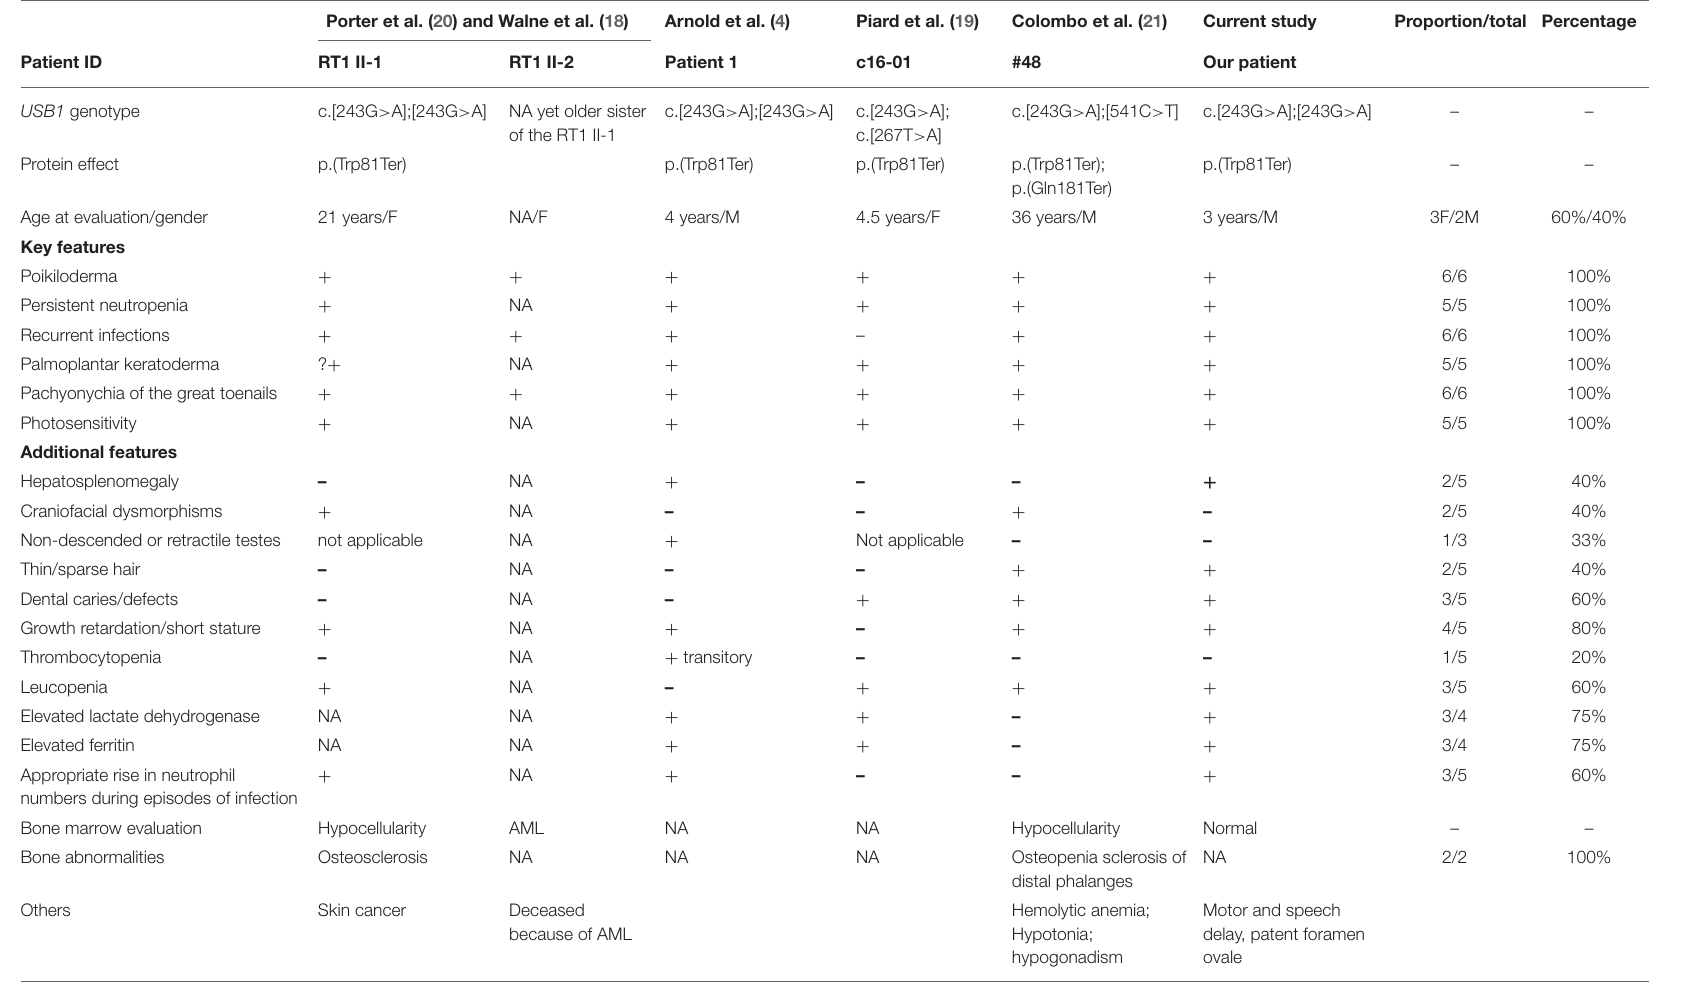
TABLE 1 | Revision of cases with the c.243G > A mutation reported at today together with the patient here